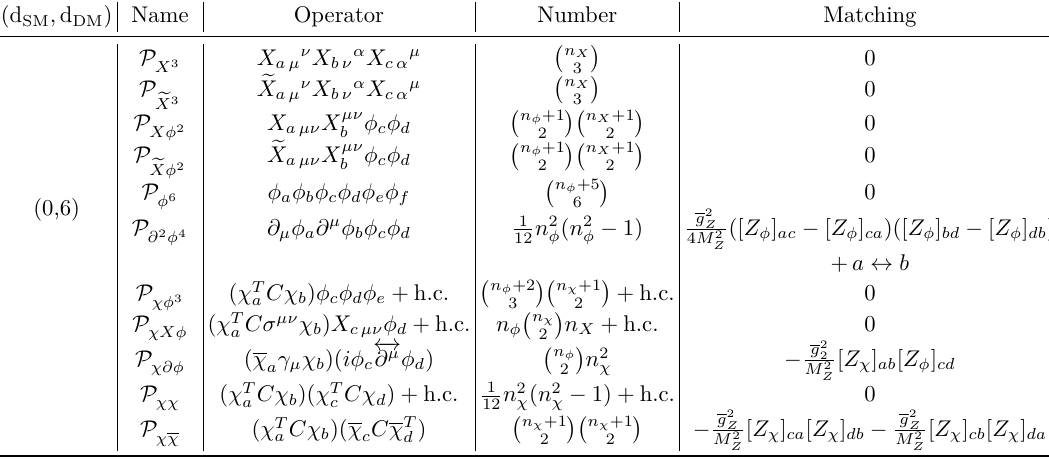
Table 7 . Dimension-six purely DM operators present in DSMEFT and DLEFT. The first column gives the dimensions of the SM and DM part of the operator, the fourth column is the number of operators, and the fifth column is the additional matching contribution at the EW